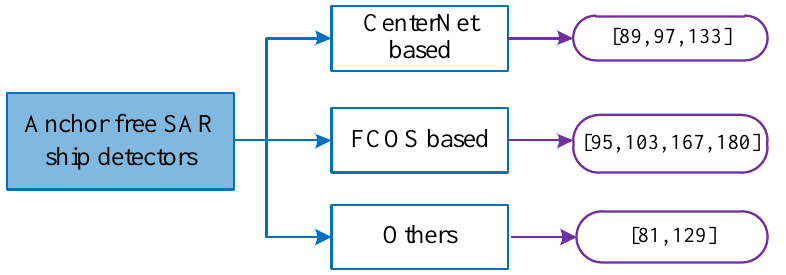
Figure 9. The anchor-free SAR ship detectors.